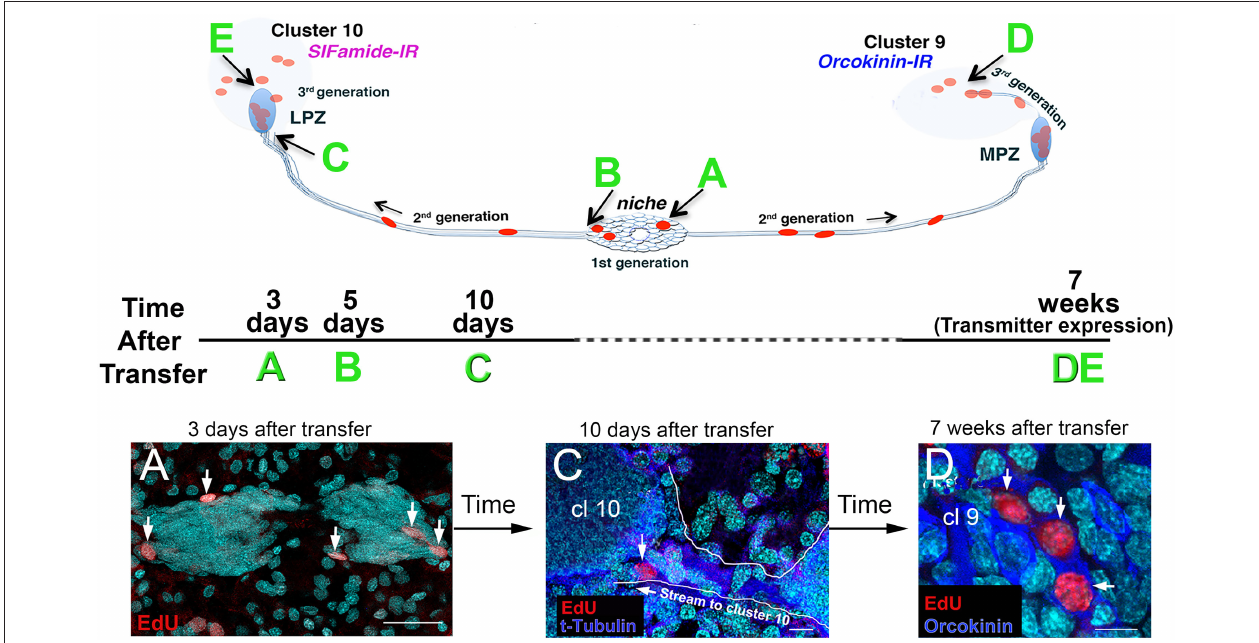
FIGURE 6 | EdU + cells were observed in the niche, streams, and in Clusters 9 and 10 of recipient crayfish after adoptive transfer of EdU + hemocytes from donor animals . The schematic diagrams illustrate (top) the locations of the EdU + cells that were observed following adoptive transfers, and (middle) the experimental timeline for each sample (time after transfer, A–E ), and (bottom) images from P. clarkii (A,D) and P. leniusculus (C) . All samples in these images (A,C,D) were labeled with the nuclear marker Hoechst 33342 (cyan). (A) Three days after adoptive transfer of hemocytes, EdU + cells (red) were observed in the niche. (C) Ten days after hemocyte transfer, cells were observed in the distal ends of the streams, near Clusters 9 and 10 (arrow). Immunoreactivity for tyrosinated tubulin (blue) highlights the migratory stream, which is also outlined in white. (D) Seven weeks after adoptive transfer of hemocytes from donor to recipient crayfish, EdU + cells (red) were observed in cell Clusters 9 and 10. Some of these cells in Cluster 9 express orcokinin, a peptide transmitter used by many Cluster 9 cells. Examples of cell labeling at B (5 days, in the niche) and at E (7 weeks, in Cluster 10) are not shown (but see Benton et al., 2014). Scale bars: (A) , 40 µ m; (C) , 10 µ m; (D) , 10 µ m. Adapted from Benton et al. (2014).